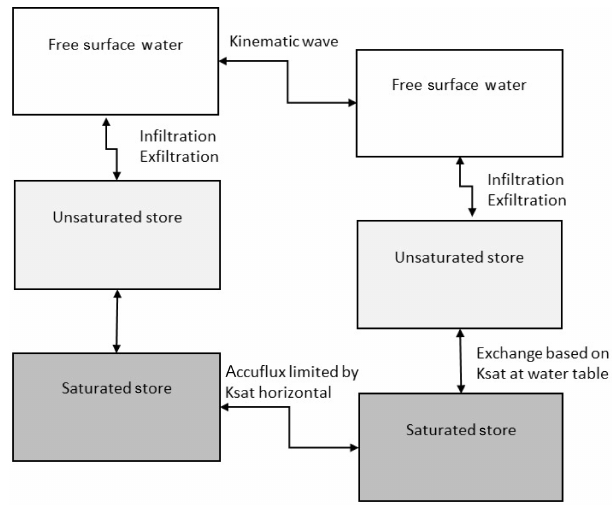
Figure 2. Schematization of the soil within the WFlow_sbm model. Source: http://wflow.readthedocs.io/en/latest/wflow_sbm.